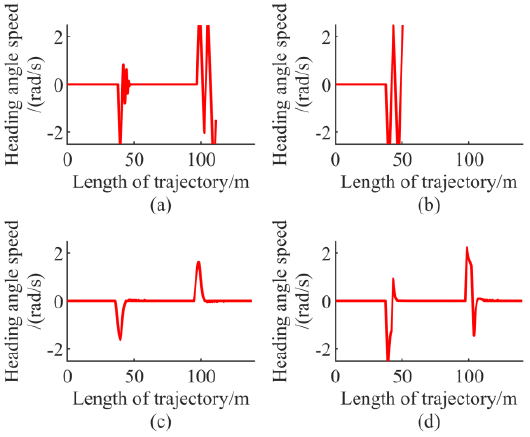
Figure 15. The heading angle speed when velocity is 4 m / s. ( a ) LMPC. ( b ) LEMPC. ( c ) NMPC. ( d ) NEMPC.